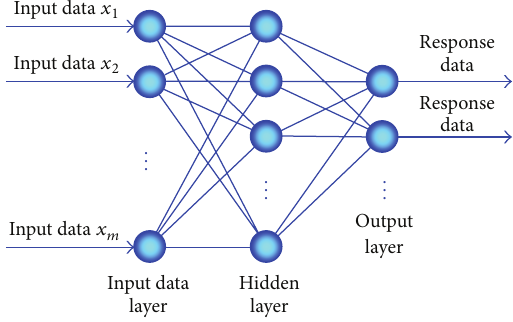
Figure 4: Multilayer perceptron (MLP) model